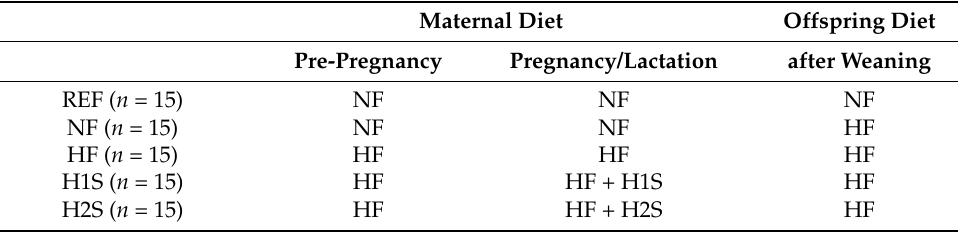
Table 1. Study Design